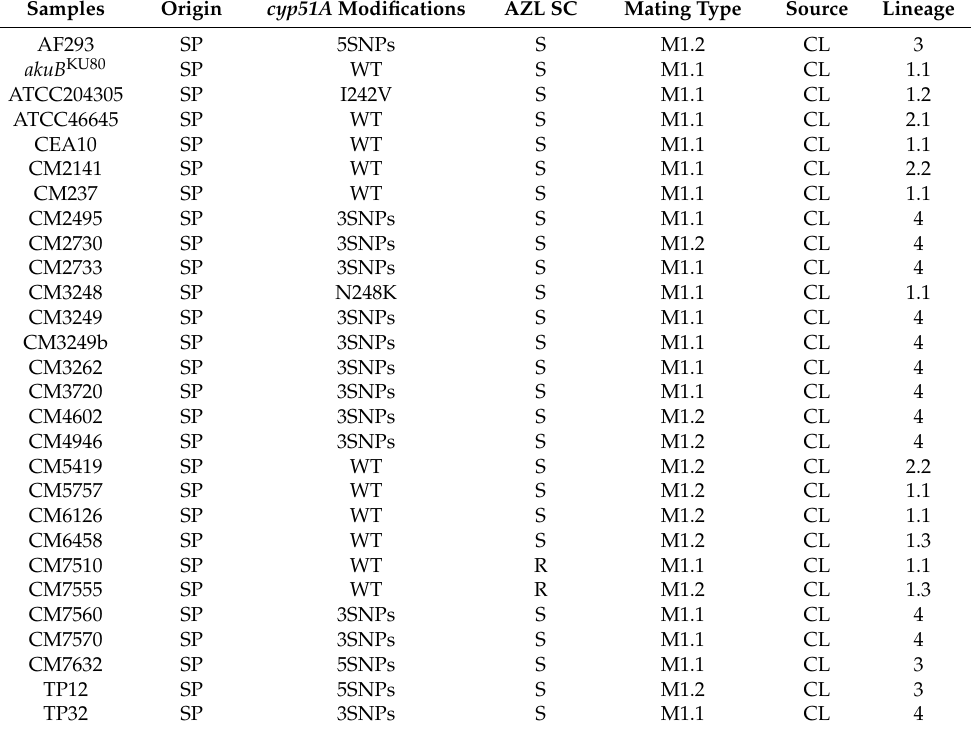
Table 1. Aspergillus fumigatus strains whole genome sequenced in our laboratory. The assigned lineage was based on the phylogenetic study.